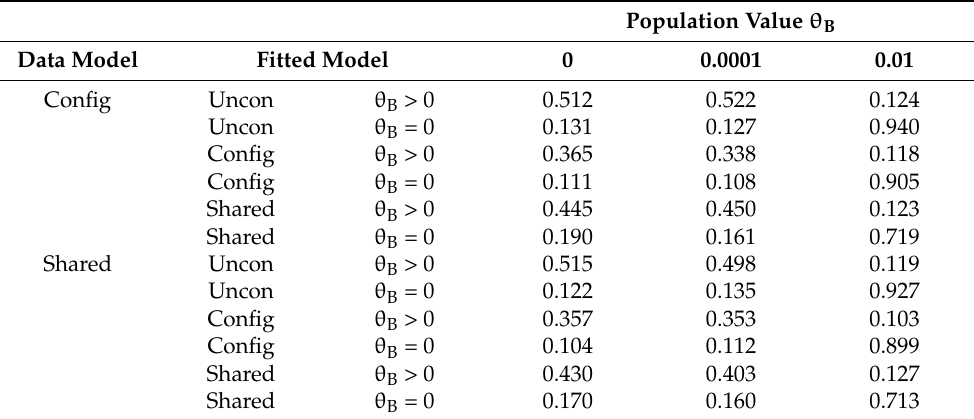
Table A3. Rejection rates with 100 clusters for MLR estimation with EMA in M plus with population θ B being zero, 0.0001, and